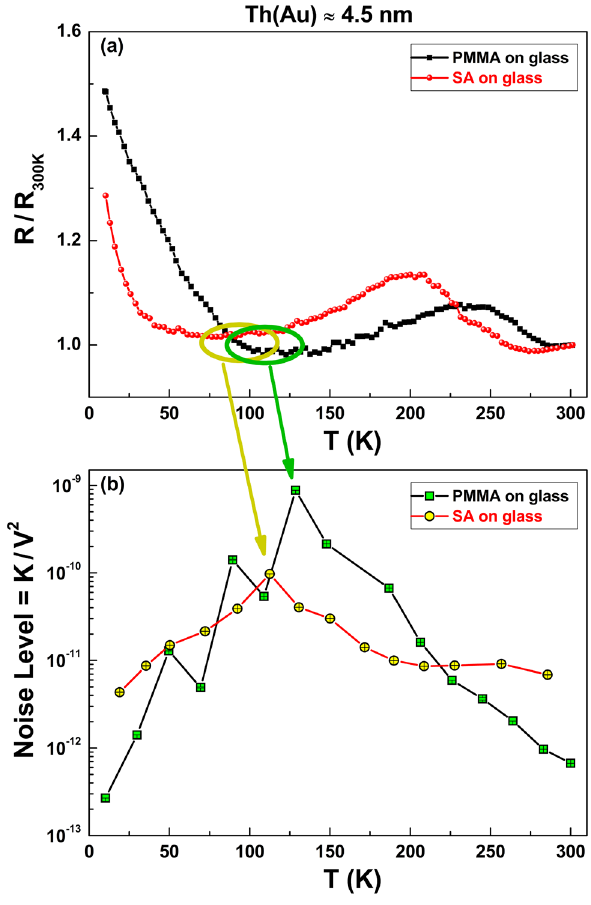
Figure 4. Comparison between DC and AC properties of non-metallic samples. The temperature dependencies of the normalized resistance R / R 300 K ( a ) and of the Noise Level NL ( b ), as evaluated from Eq. (2), are shown for PMMA (squares) and SA (circles) films. The NL peaks, corresponding to the different resistance minima observed, are evidenced with green and yellow arrows for PMMA and SA,